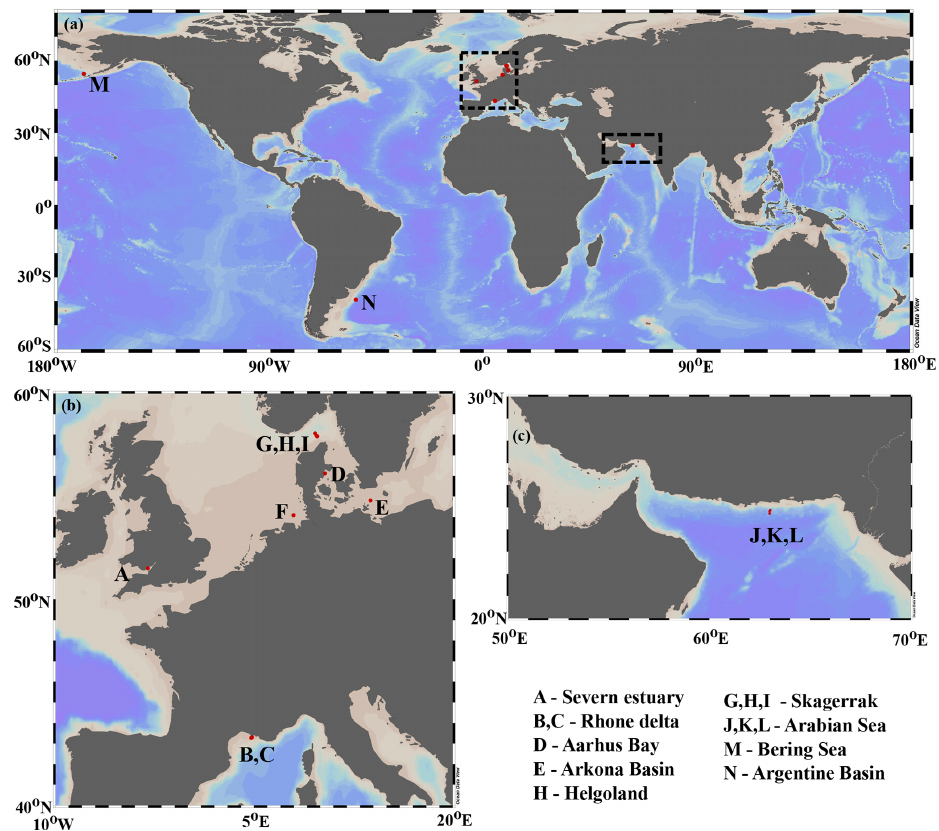
Figure 1. Depositional environment geographic locations. (a) Global scale; (b) European margin; (c) Arabian Sea region. Map produced with Ocean Data View (Schlitzer,